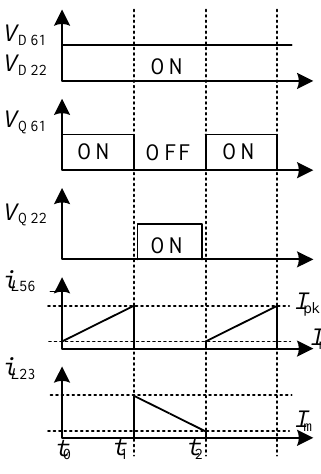
Figure 8. The current paths of Case 2.